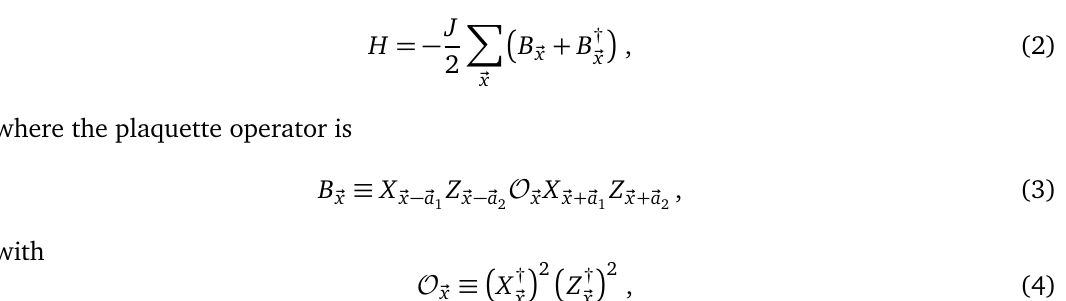
Figure 1: Lattice spanned by the lattice vectors ⃗ a B ⃗ x